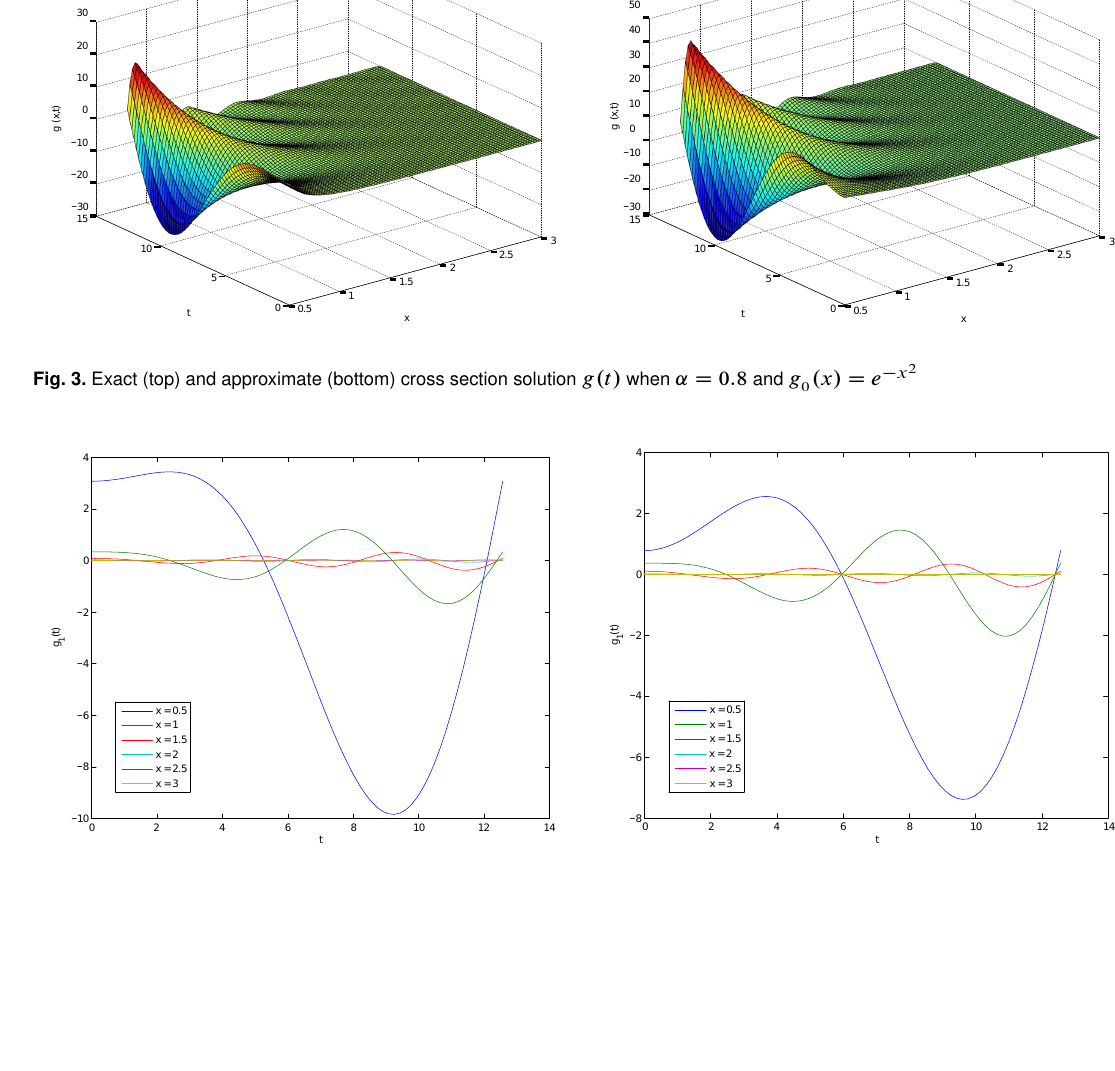
Fig. 2. Exact (top) and approximate (bottom) surface solution g.x;t/ when ˛ D 0:8 and g 0 .x/ D sin x